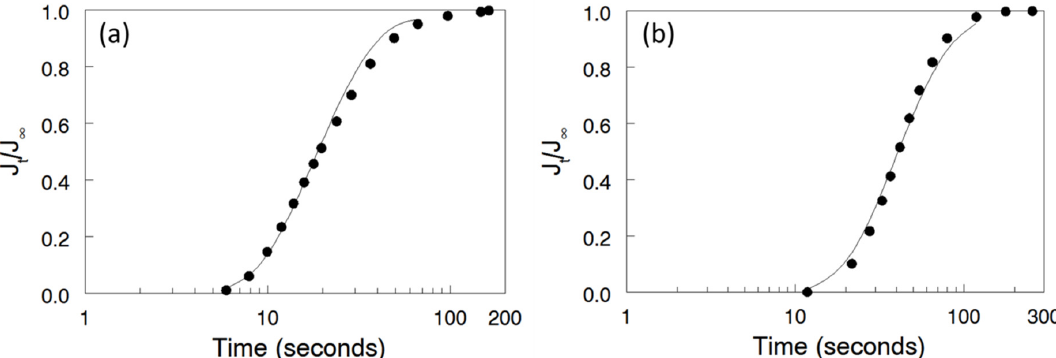
Figure 5. Fit of experimental data to the transient breakthrough model for: ( a ) Nafion ® 115; and ( b ) 57 vol% N (fibers)/PPSU nanofiber composite membrane. Figure 5a adapted with permission from ECS Transactions, 50 (2) 1217 (2012). Copyright 2012, The Electrochemical Society.